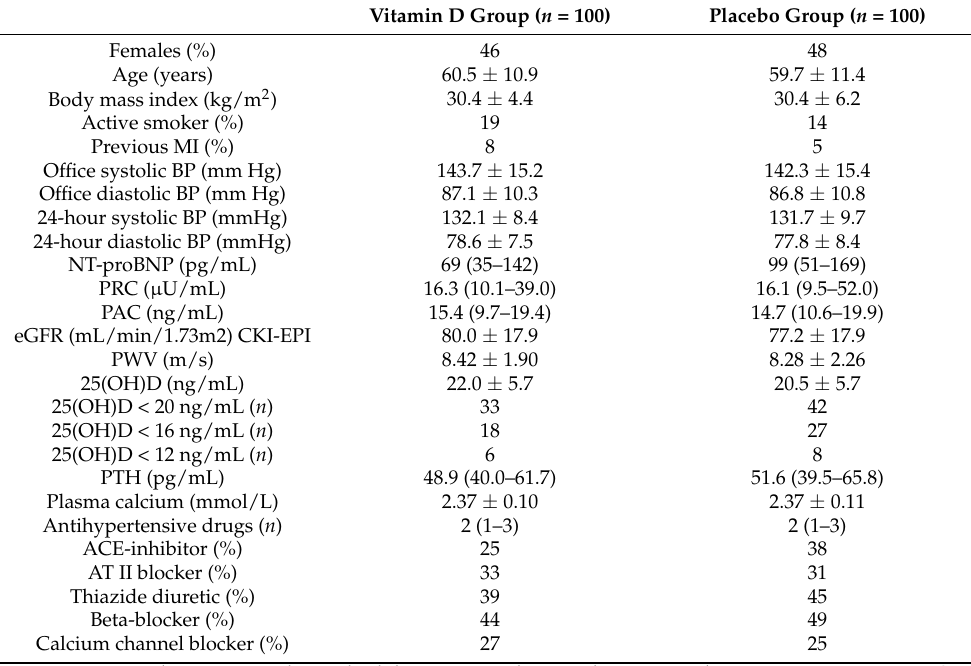
Table 1. Selected baseline characteristics of all randomized study participants, as previously published